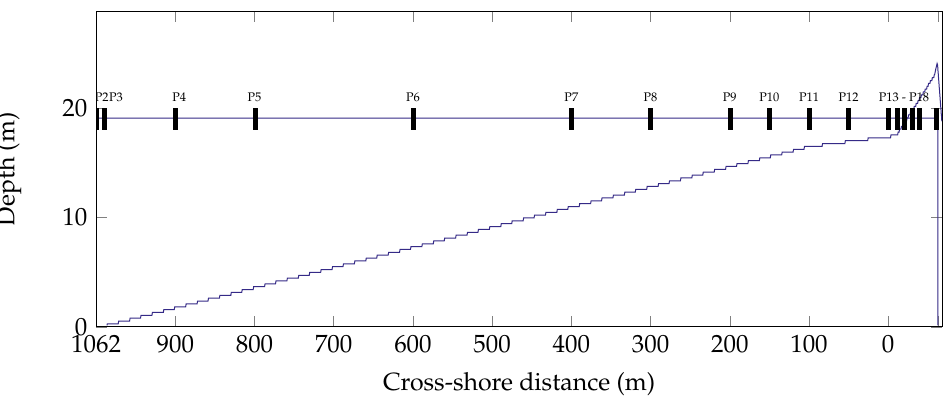
Figure 6. Domain of NEWRANS model including probe